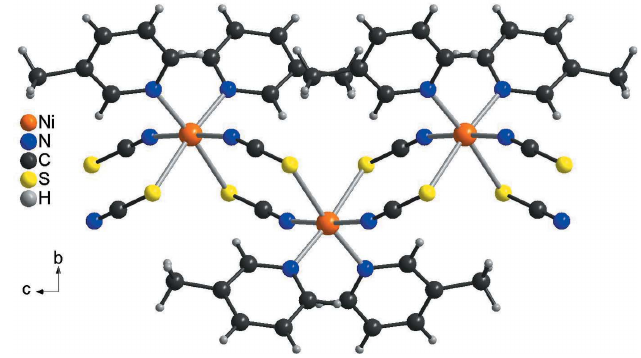
Figure 2 Crystal structure of the title compound with labeling and displacement parameters drawn at the 50% probability level. Symmetry codes: (A) (cid:3) x + 1, y , (cid:3) z + 1 ; (B) (cid:3) x + 1, (cid:3) y , (cid:3) z ; (C) x , (cid:3) y , z + 1 2